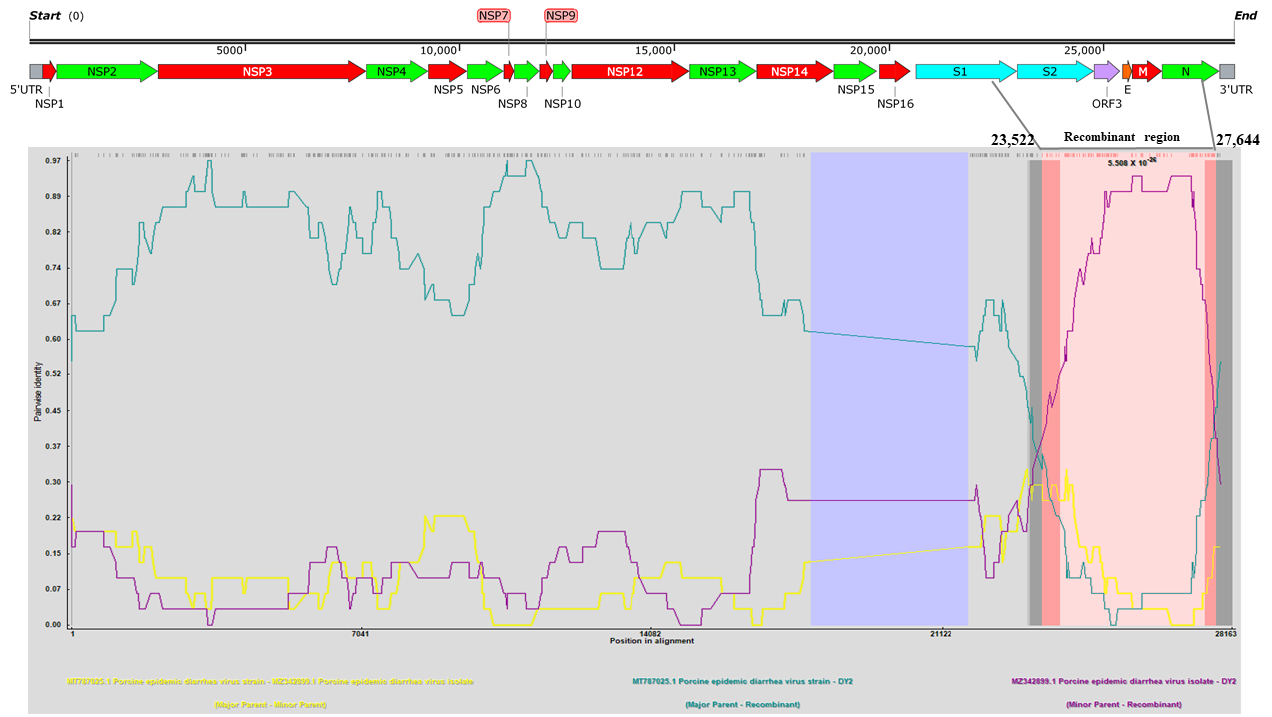
Figure 5. The recombination analysis of the complete genome of PEDV DY2020 strains isolated in this study. The results were described using the RDP method, which was supported by ≥ 6 programs to further characterize the potential recombination events. The pink box indicates the regions for the occurrence of recombination events. The Y -axis represents the pairwise identity between the recombinant and its putative parents. The X -axis represents the position in alignment with a 30 nt sliding window. The comparison of the recombinant-major parent, recombinant-minor parent, and major-minor parent was indicated by cyan, purple, and yellow lines, respectively.